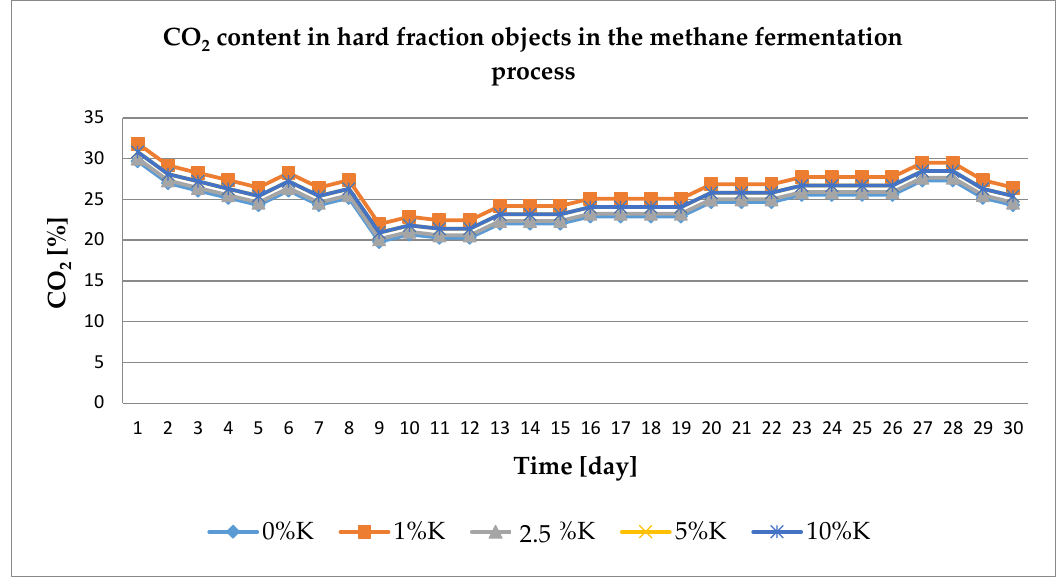
Figure 6. Carbon dioxide content in hard fraction objects in the methane fermentation process.